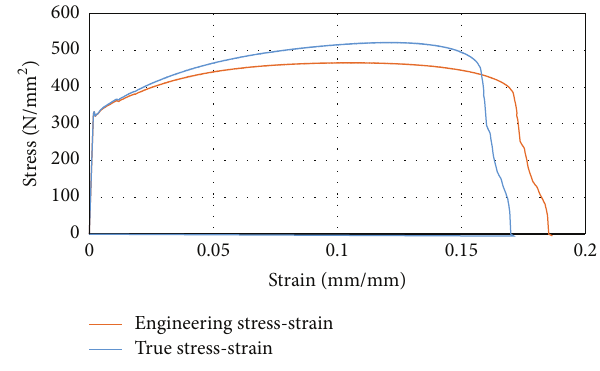
Figure 10: Material properties for true stress-strain and engineering stress-strain.